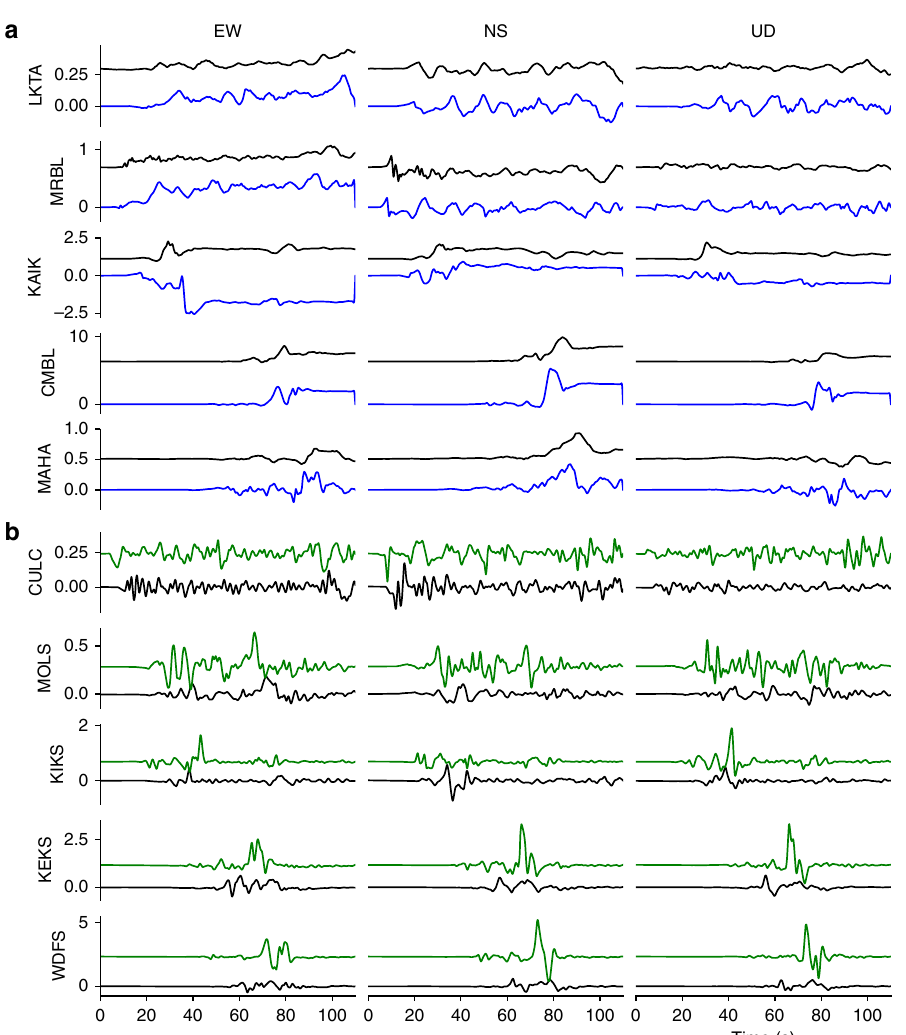
Fig. 9 Comparison of modeled and observed ground motions. a Synthetic (blue) and observed (black) ground displacements at selected Global Positioning System (GPS) stations. A 1 s low-pass fi lter has been applied to both signals. b Synthetic (green) and observed (black) ground velocities at selected strong- motion stations. A 0.005 – 1 s band-pass fi lter has been applied to both signals. The station locations are shown in Fig. 8. The station names are labeled on the vertical axis of each